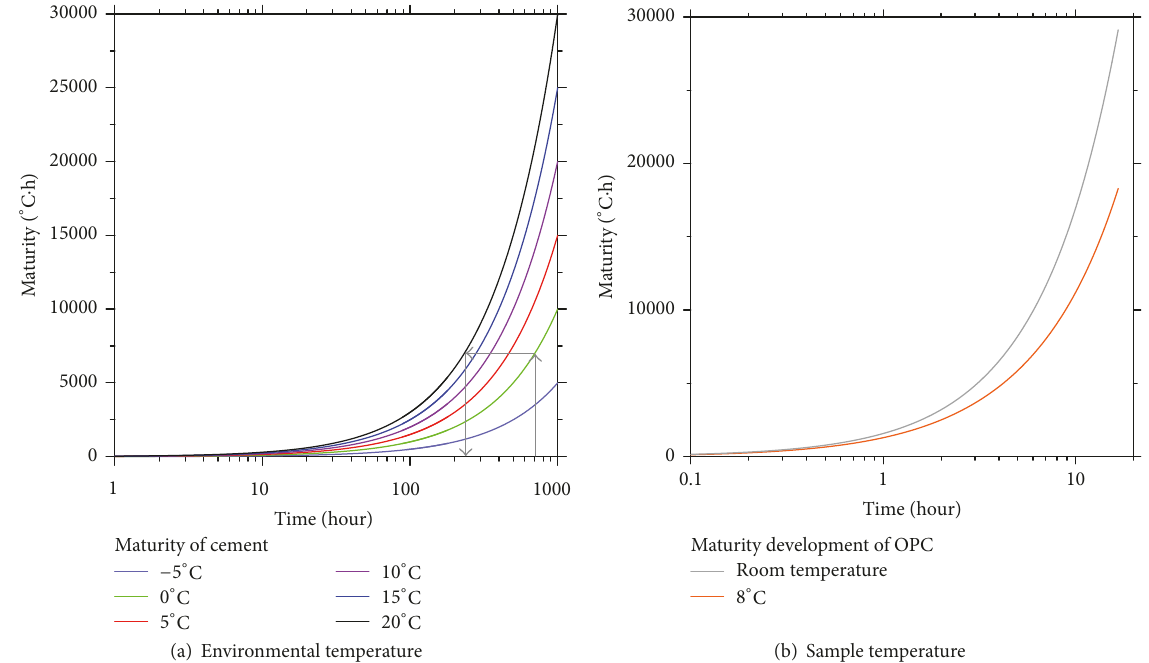
Figure 5: Maturity development of cement